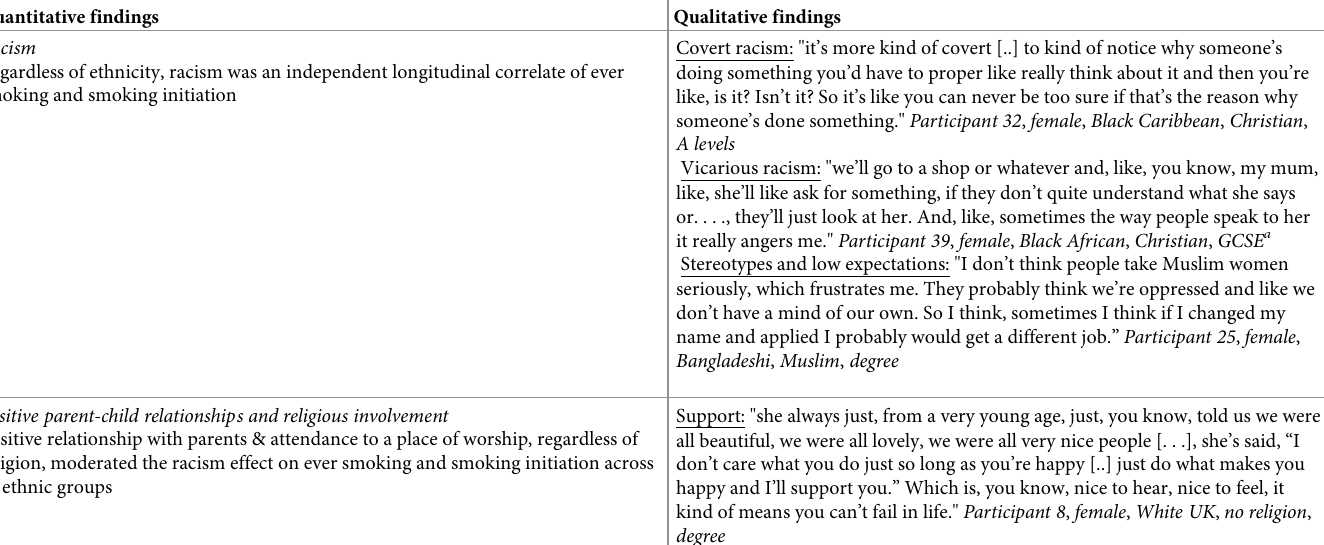
Table 7. Qualitative findings, the determinants of Adult Social well-being and